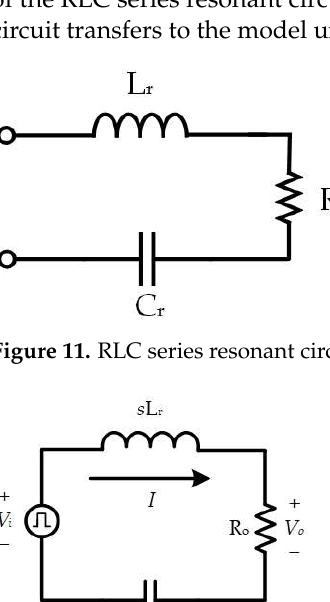
Figure 12. RLC series resonant equivalent circuit under the frequency domain.